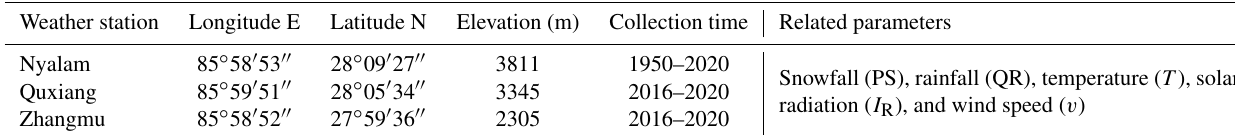
Table 2. Information about meteorological stations and meteorological data. Weather station